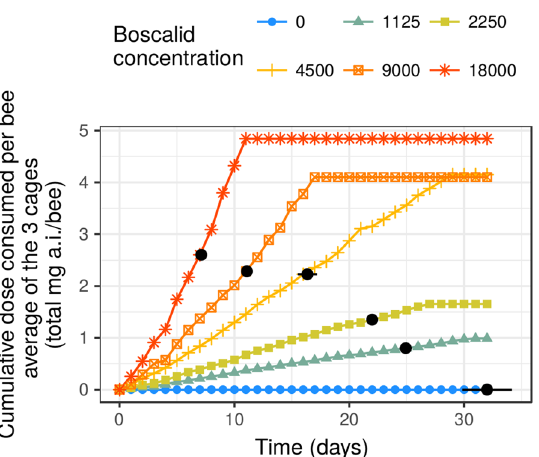
Figure 5. Log-log regression of LDDx vs. Time compared to the regression line expected in the absence of cumulative toxicity. The dashed lines show regression lines with a fixed − 1 slope (the models estimate only the intercepts). This is the expected relationship under Haber’s law i.e. without cumulative toxicity. The slopes of the observed linear regression are significantly lower than − 1, which implies some level of cumulative toxicity. However the log-log relationship is clearly not linear at least for the lowest mortality rates. The representation of the log-log regressions for the other toxic endpoints can be found in Suppl. Mat., Section 5.1. along with confidence intervals of the slopes (Fig. S20).